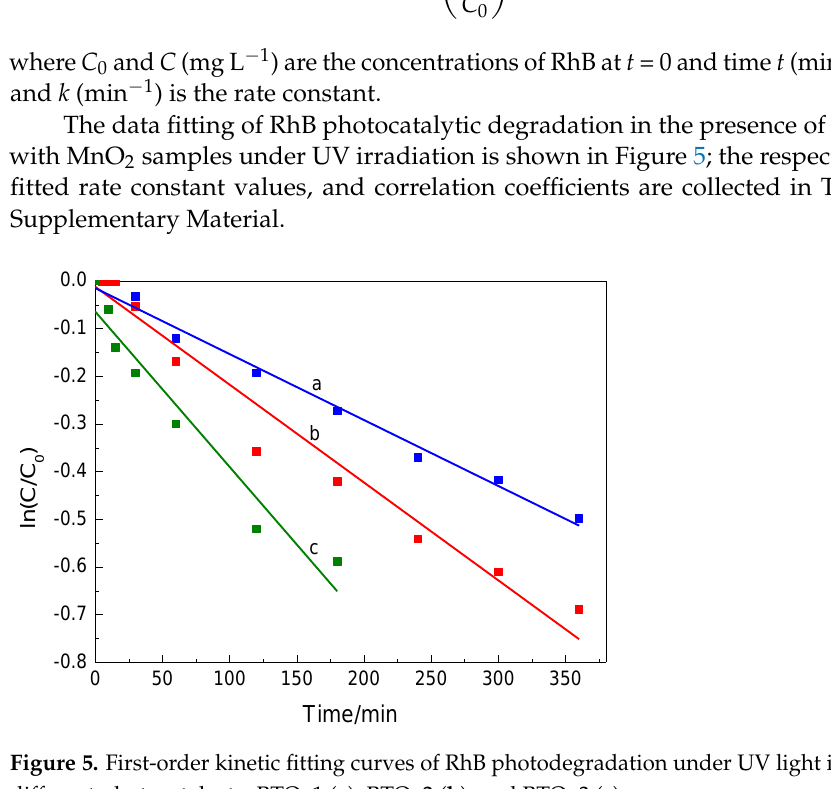
and k (min − 1 ) is the rate constant.